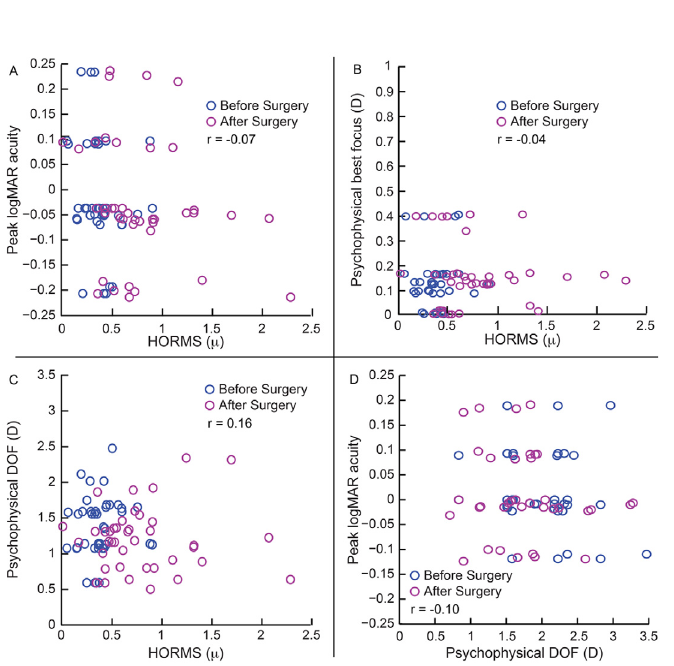
Fig 6. Relation between peak high contrast logMAR acuity, psychophysical best focus, psychophysical high contrast DOF and HORMS obtained from the second arm of the study. All other details are similar to Fig